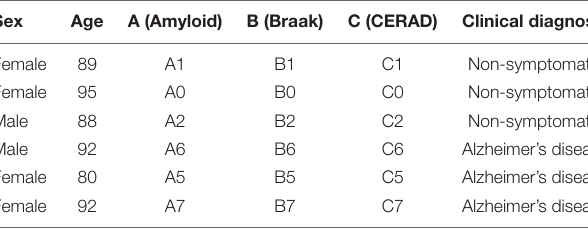
TABLE 5 | Clinical characterization of post-mortem brain patient